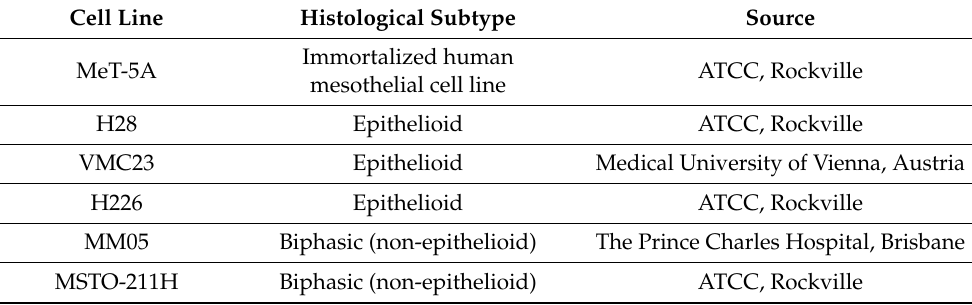
Table 1. List of cell lines used in this